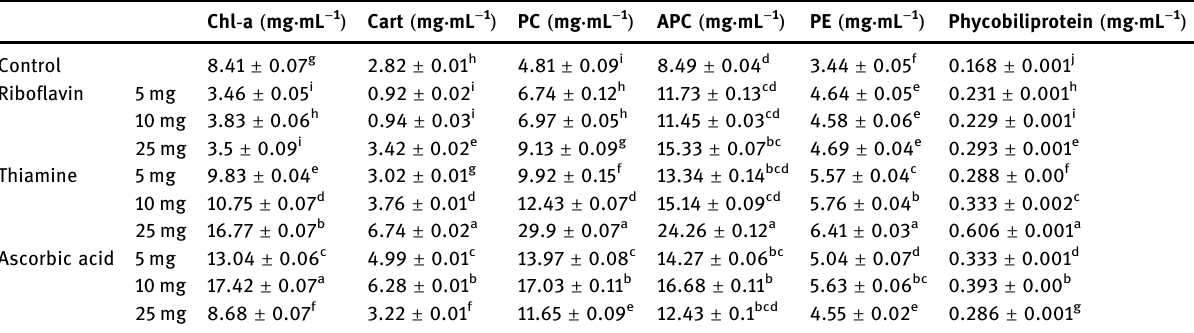
Table 2: Mean values of chlorophyll, carotenoids, and phycobilins concentrations ( mg · mL − 1 ) in SP supplemented with various concen - trations of ribo fl avin, thiamine, and ascorbic acid for 7 days of